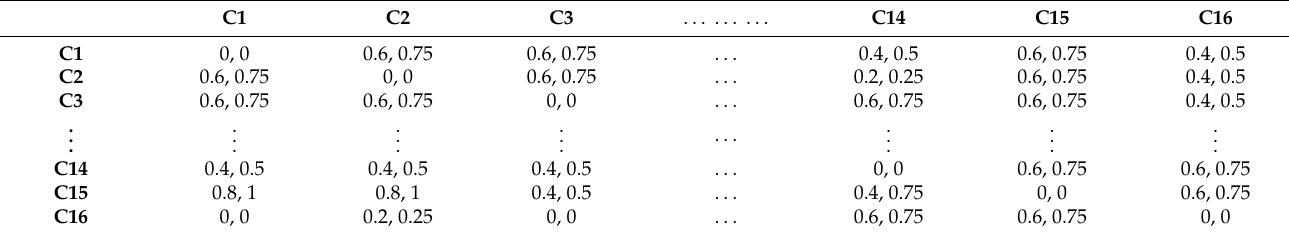
Table 6. Left and right normalized values.